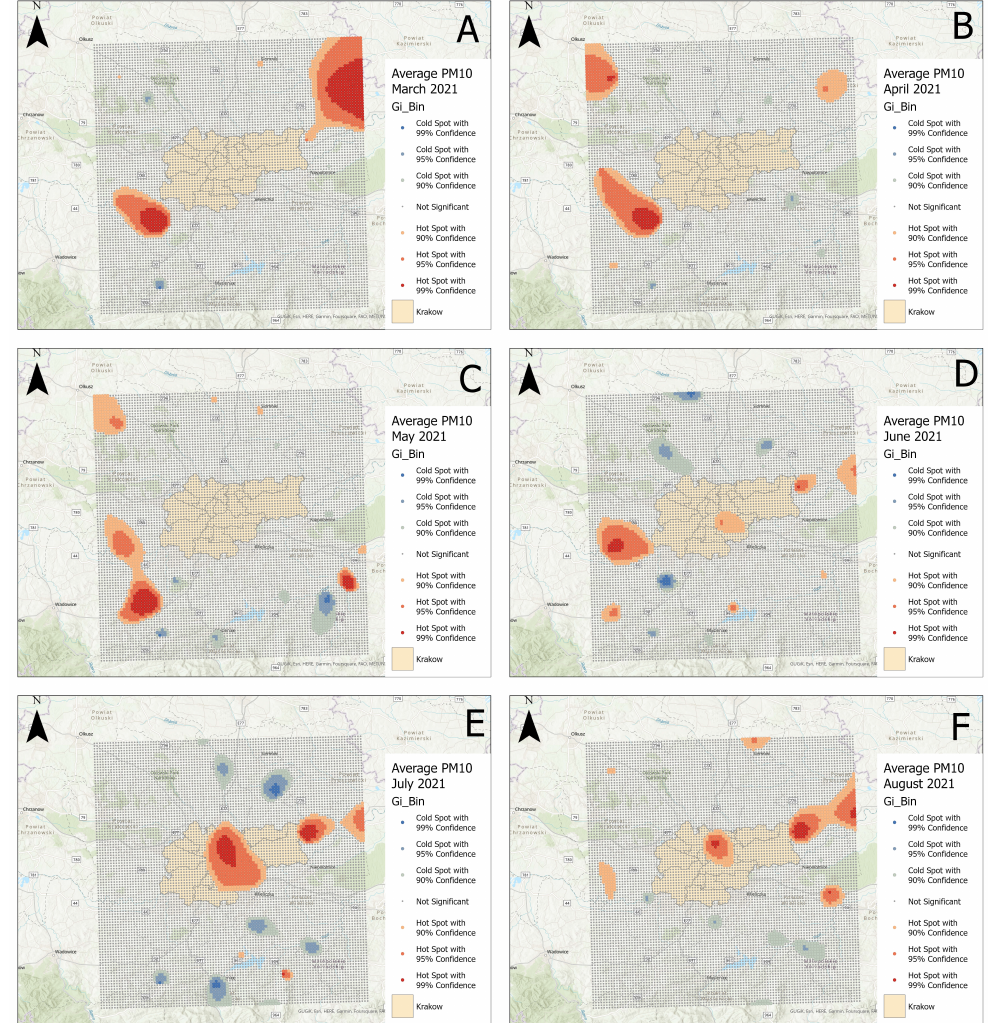
Figure 13. Hot-spots and cold-spots maps for monthly average PM10 concentration using Getis-Ord G ∗ . The maps illustrate clustering in March ( A ), April ( B ), May ( C ), June ( D ), July ( E ), and August i 2021 ( F